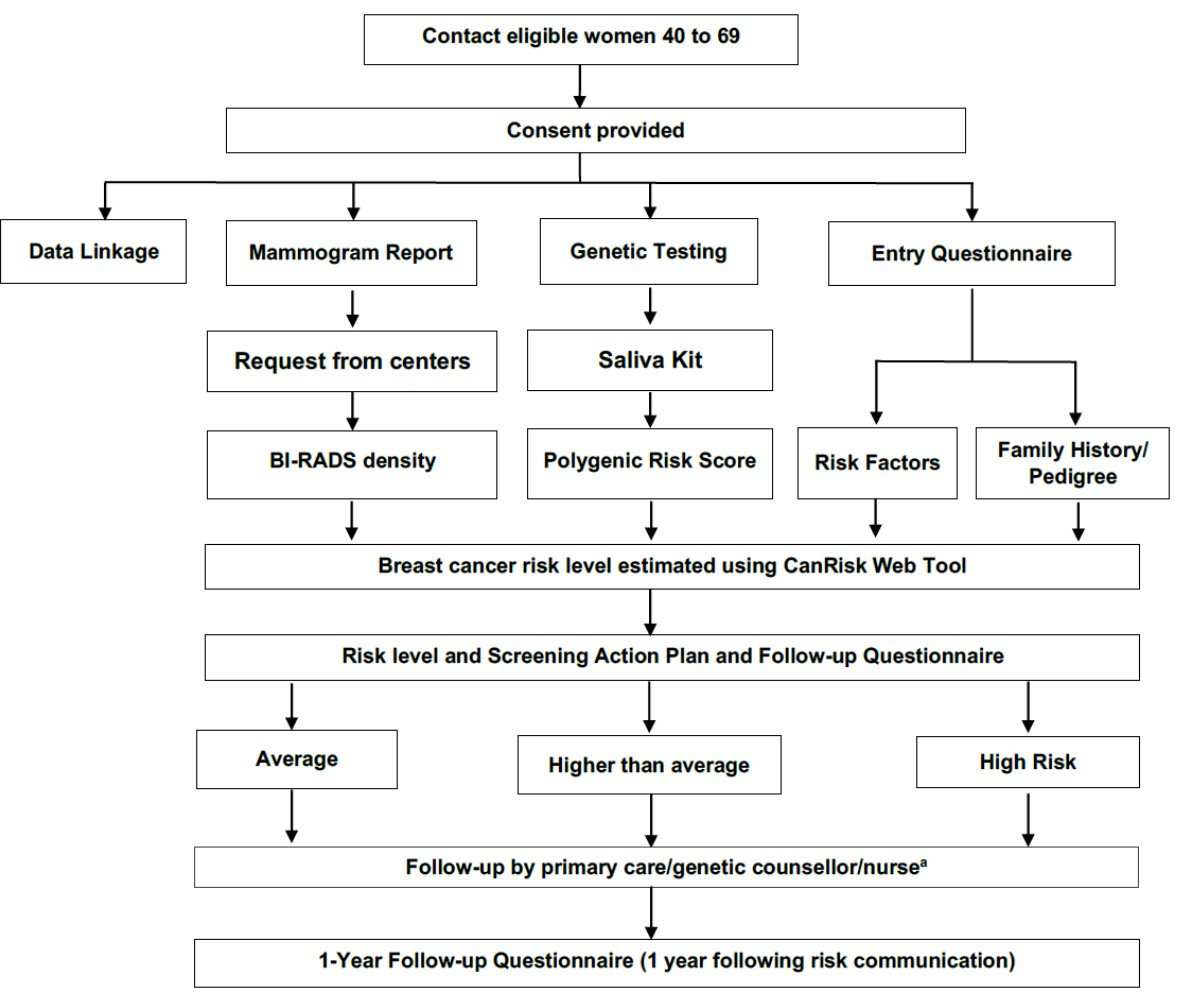
Figure 3. Data collection pathway for the PERSPECTIVE I&I Project. a upon request for Average and Higher than average risk categories.